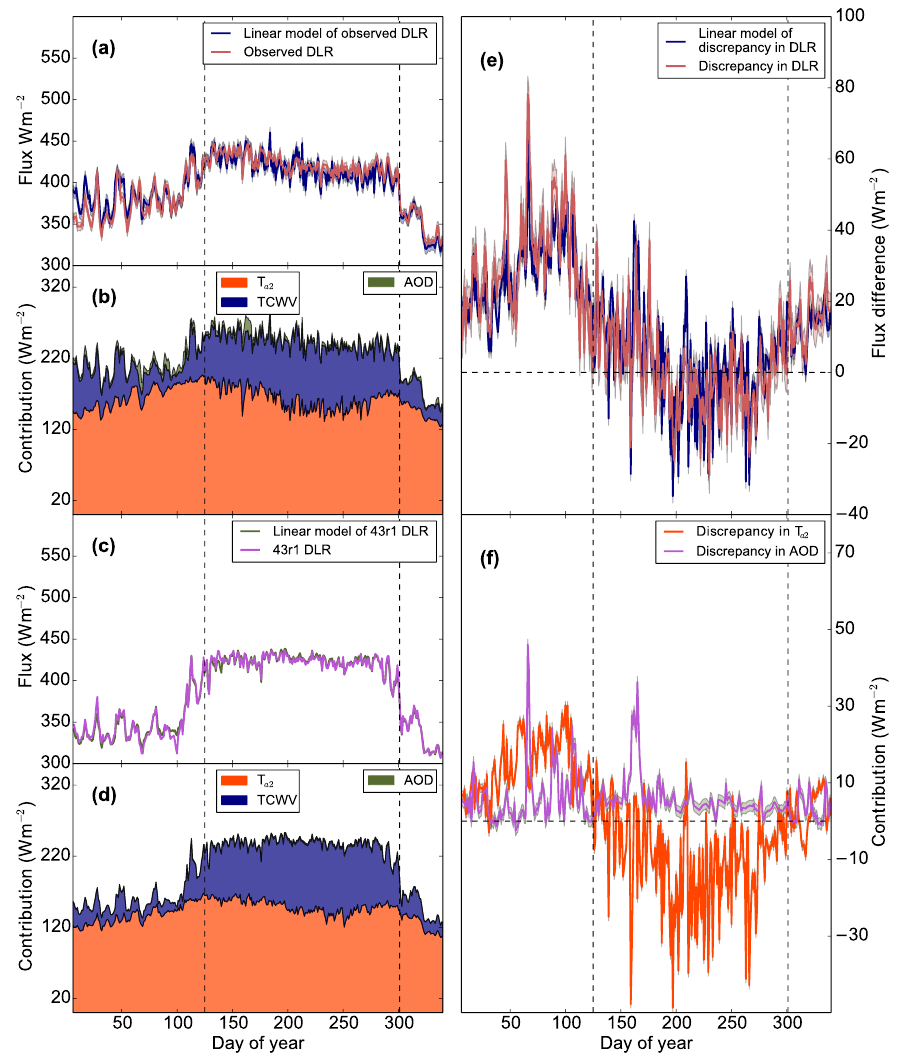
Figure 9. The same as Fig. 7 but for downwelling longwave radiation, with observation–43r1 linear model contributions from TCWV (blue), 2m air temperature (orange) and AOD (green) in plots (b) and (d) , and discrepancy model contributions from 2m air temperature (orange) and AOD (pink) in plot (f)